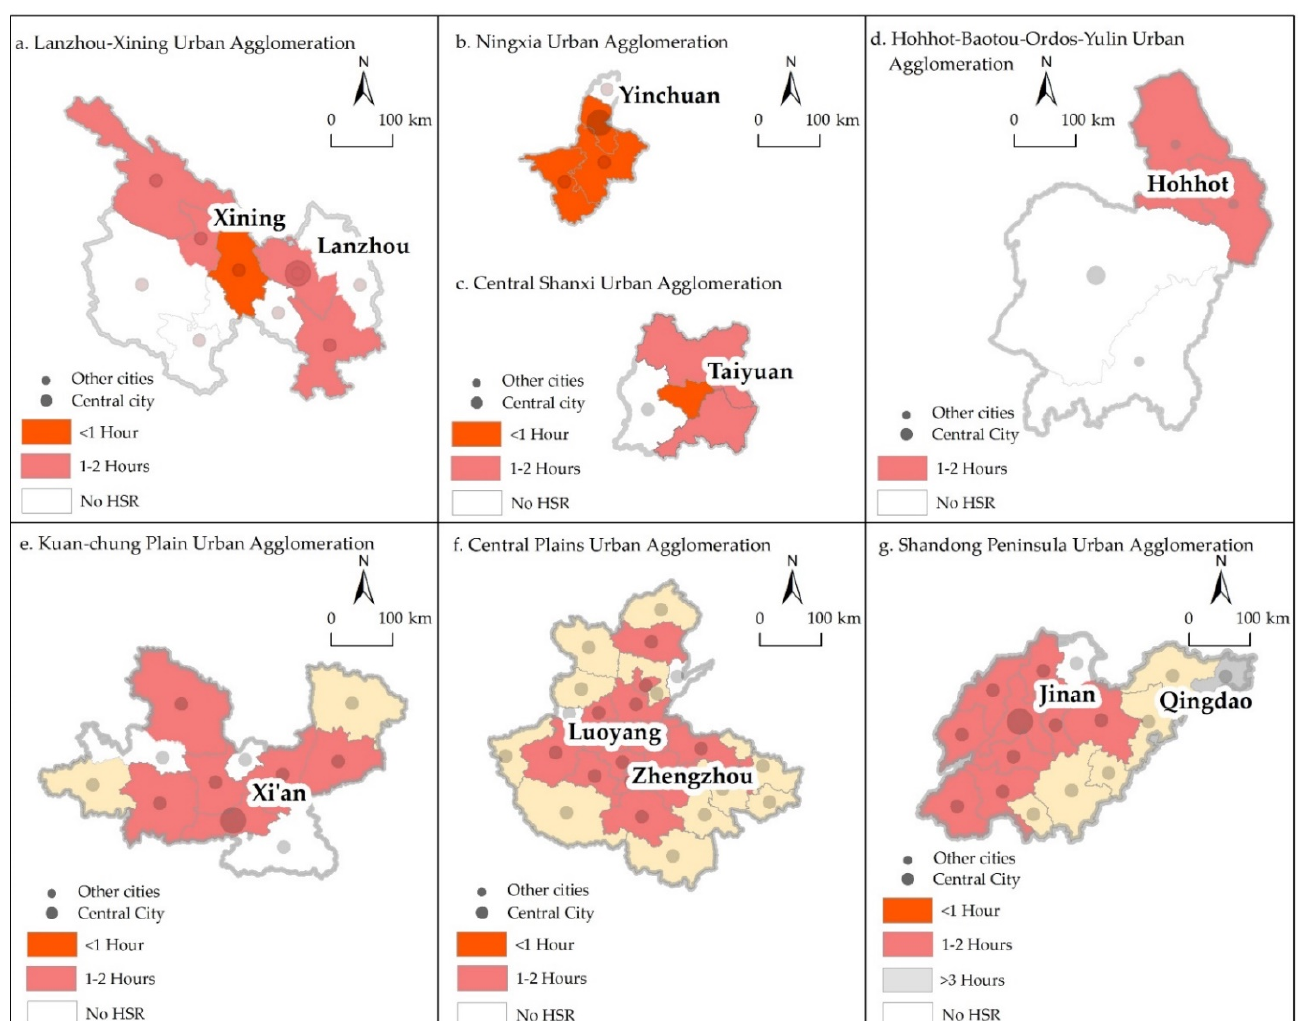
Figure 3. City access patterns within each urban